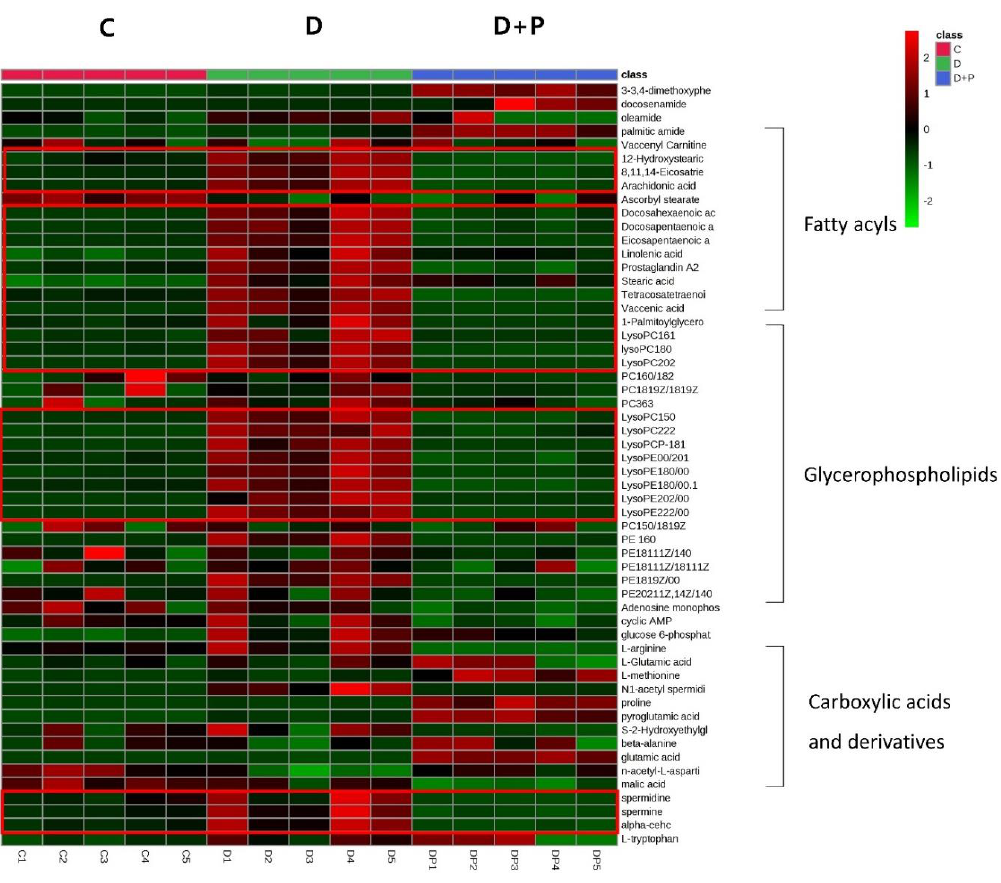
Figure 5. Hierarchical cluster analysis of identified metabolites. The metabolites were clustered, and shades of green and red represent downregulation or upregulation.